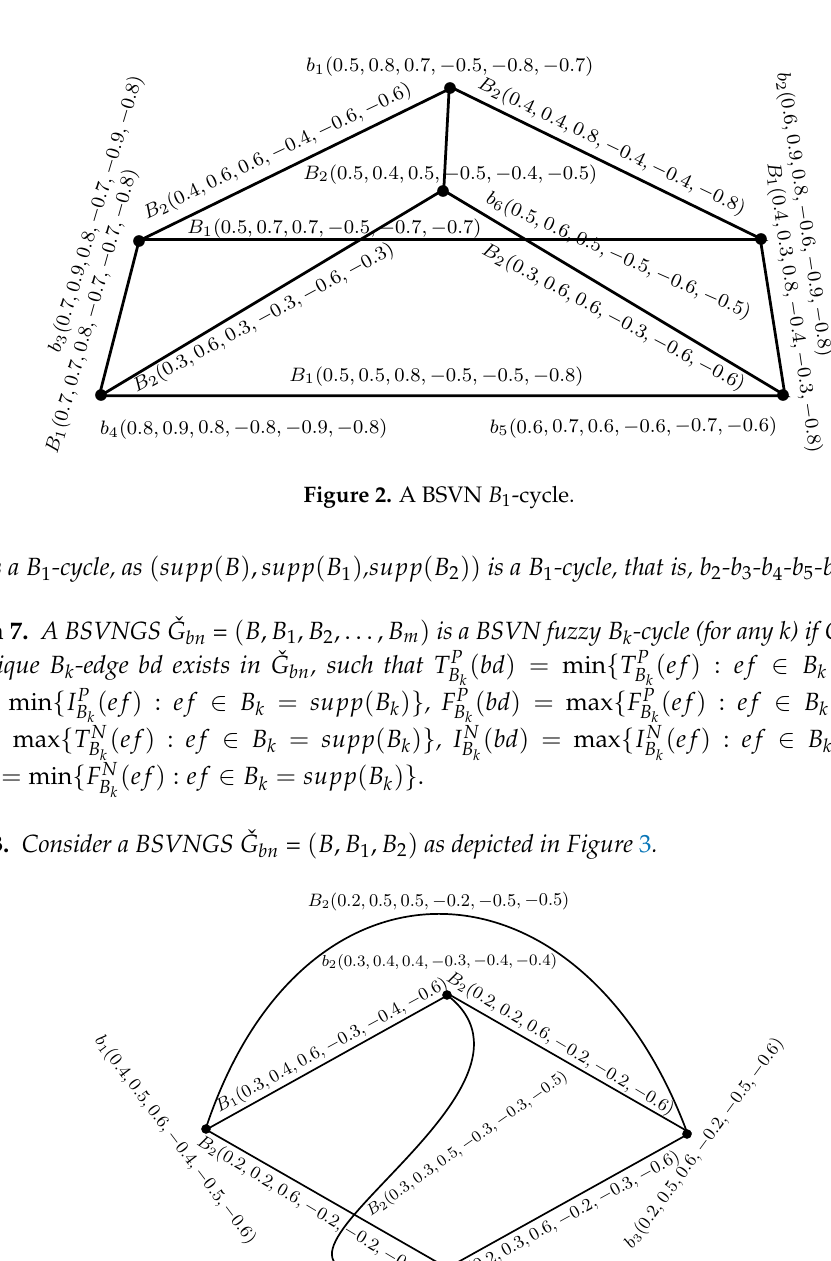
Figure 2.3: A bipolar single-valued neutrosophic fuzzy B 2 -cycle Figure 3. A BSVN fuzzy B 2